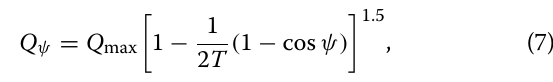
Figure 4 Contact